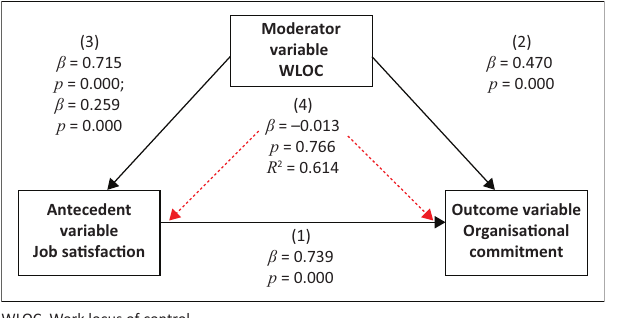
WLOC, work locus of control. FIGURE 6: Mediation analysis between job satisfaction, work locus of control and organisational commitment.